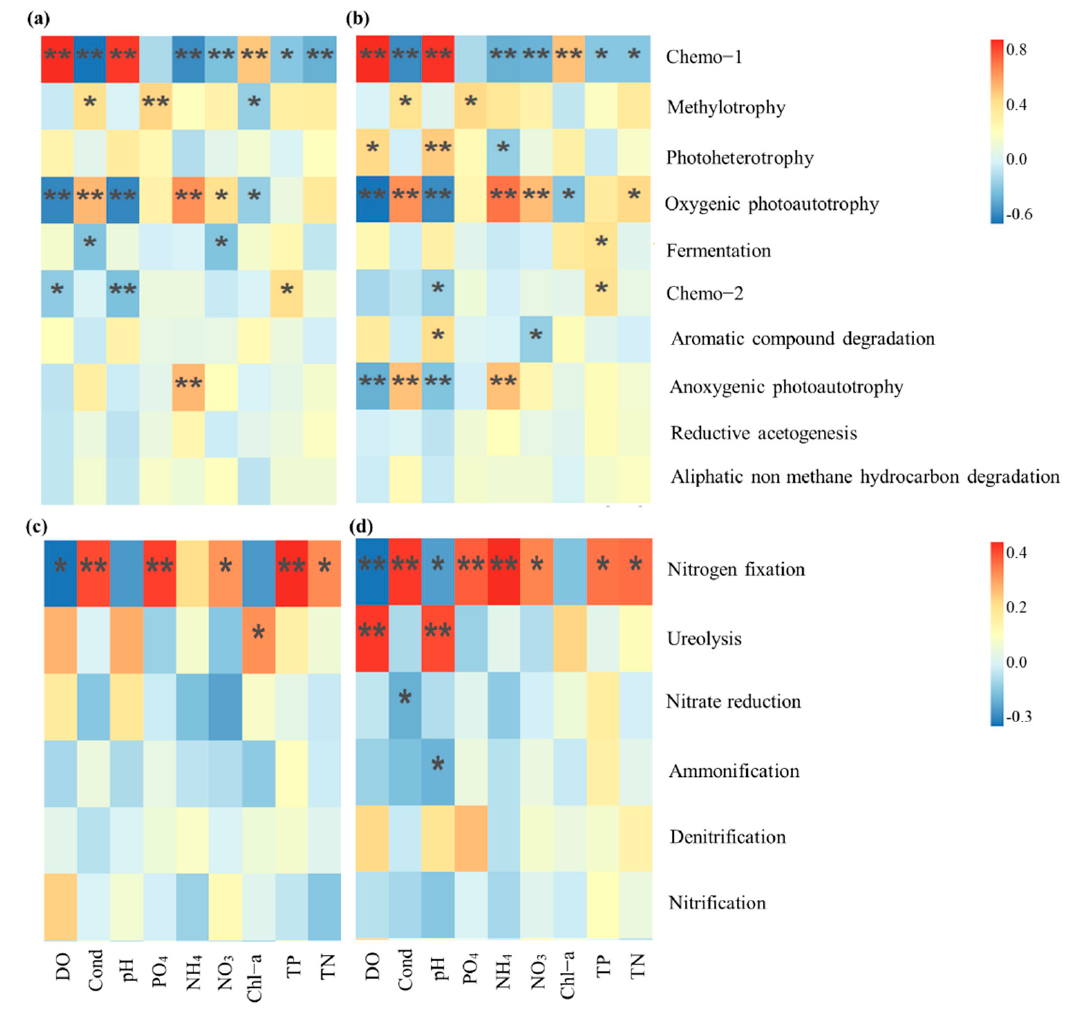
Figure 6. Heatmap correlation between relative abundance bacteria functional groups related to carbon and nitrogen cycles in leaf and stem litter and environmental factors. ( a ), leaf litter (related to carbon cycle); ( b ), stem litter (related to carbon cycle); ( c ), leaf litter (related to nitrogen cycle); ( d ), stem litter (related to nitrogen cycle). Level of significance at p < 0.05 and p < 0.01 is denoted by * and **, respectively.